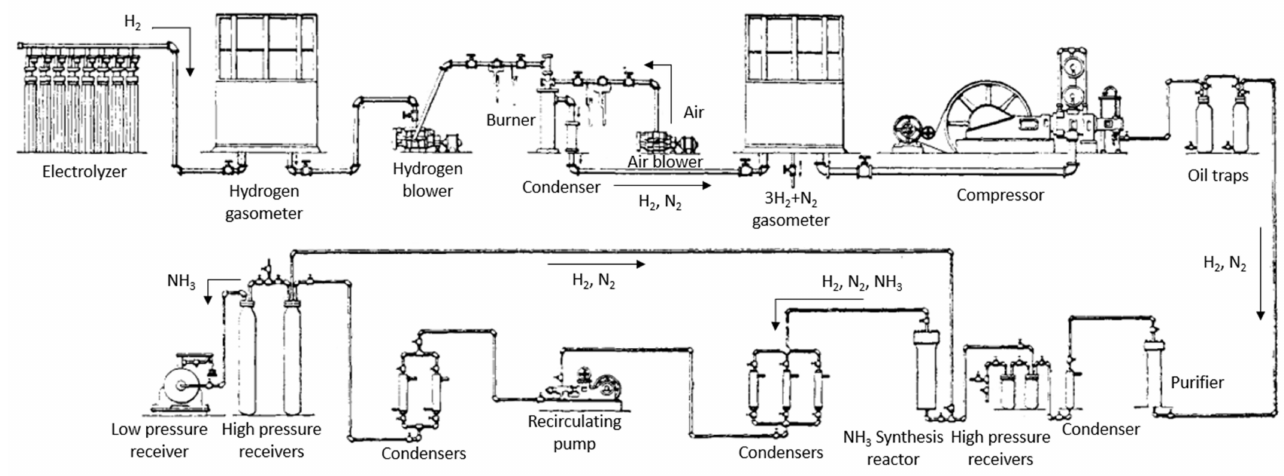
Figure 2. Schematic overview of an electrolysis-based ammonia synthesis plant. Reprinted with permission from Ref. [19]. 1925, ACS